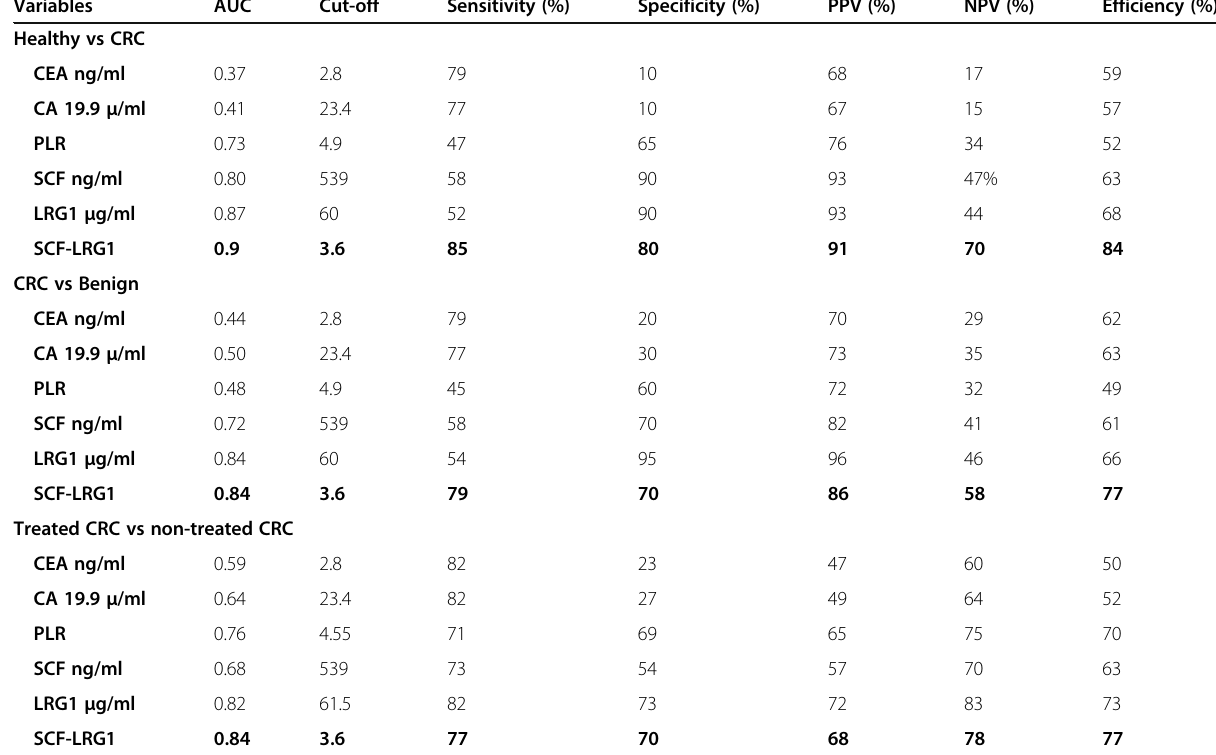
Table 3 Diagnostic performances of single and combined markers Variables